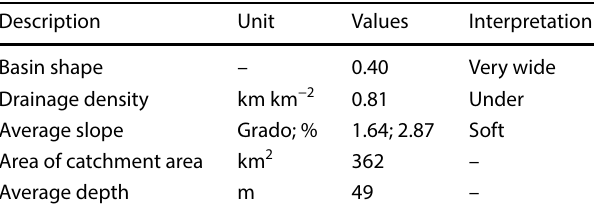
Fig. 3 Location and physical-geographical characteristics of the basin in the Southern Karstic Plain Havana—Matanzas, Cuba Table 2 Main morphometric parameters of the La Teresa karst basin (Taken from Febles et al.